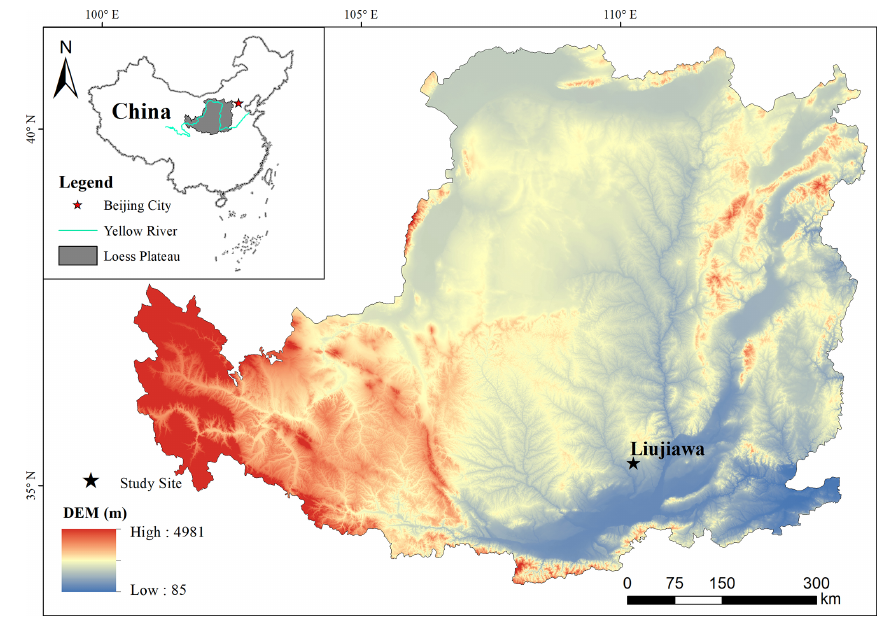
Figure 1. Location of sampling site on the Chinese Loess Plateau.